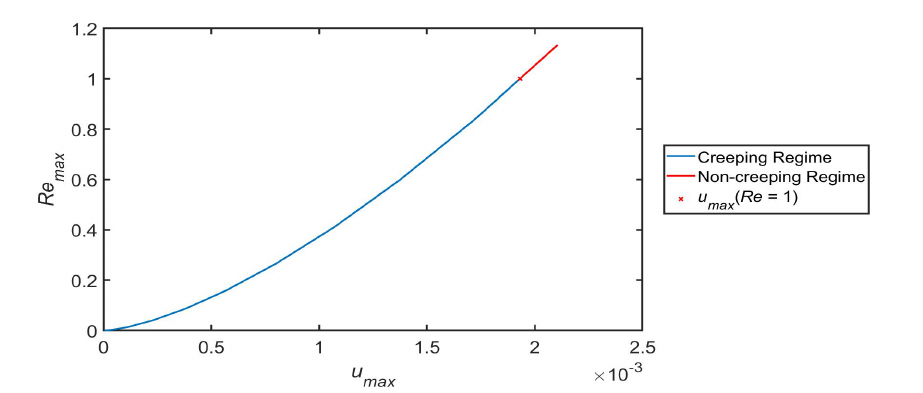
Figure 4. Maximum Reynolds ( Re max ) number as a function of maximum velocities ( U max